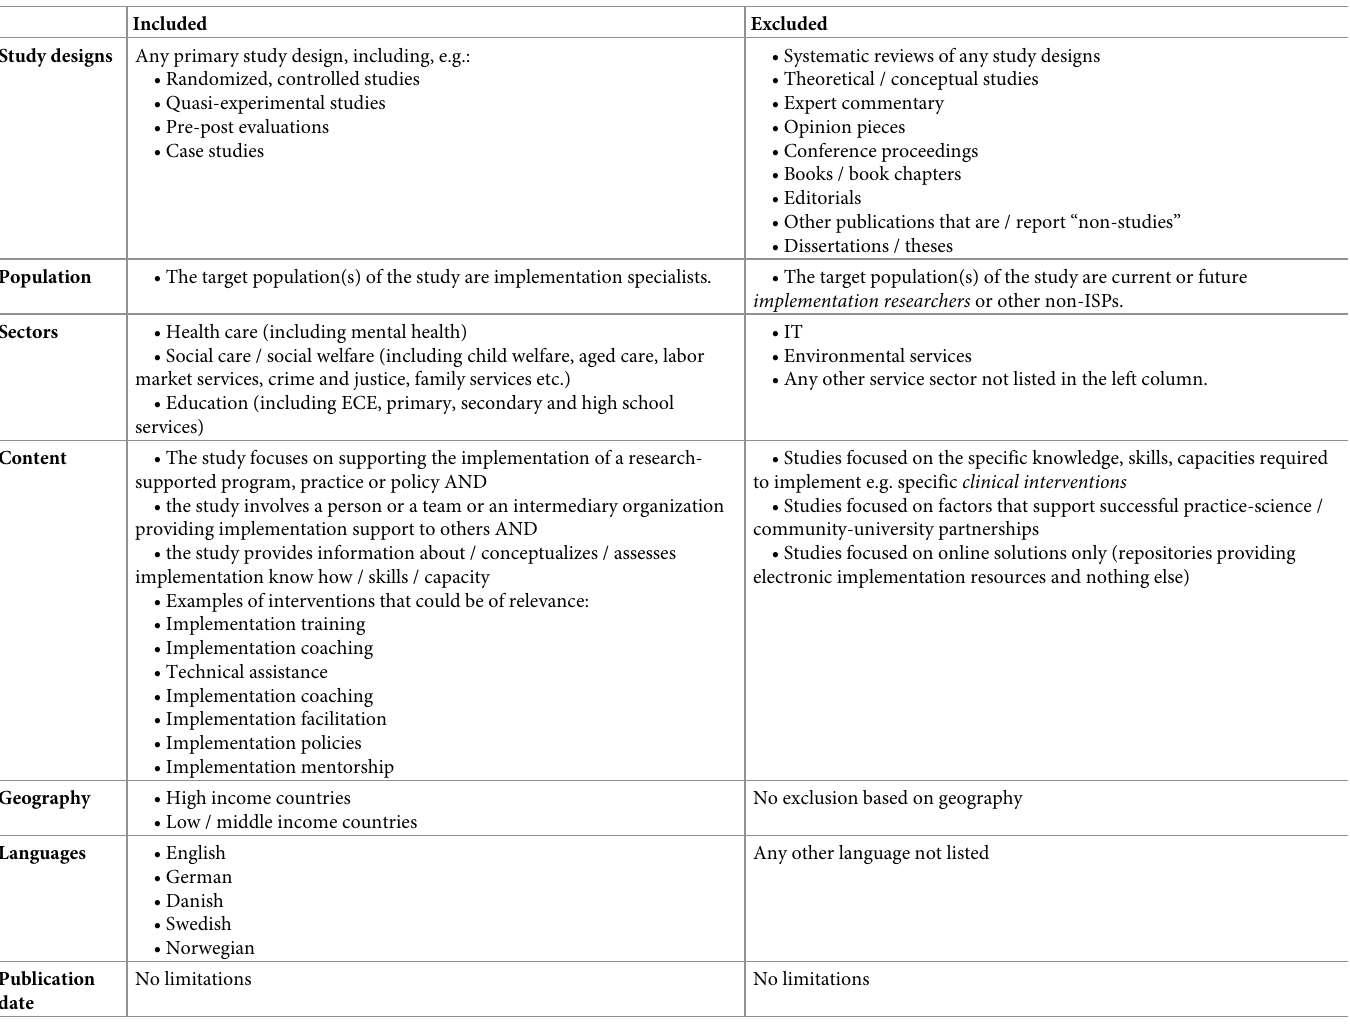
Table 1. Overview of inclusion and exclusion